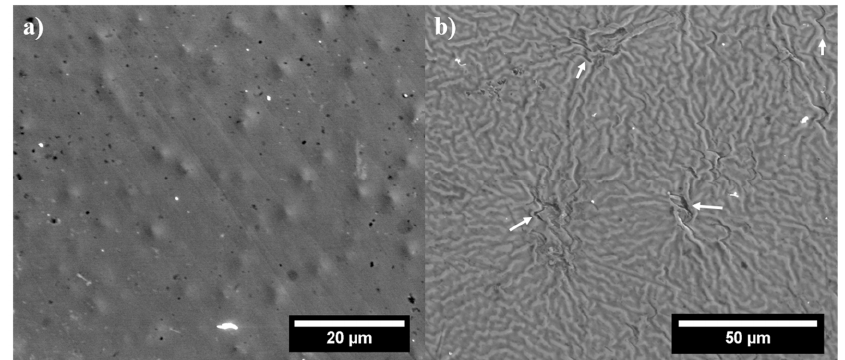
Figure A1. SEM images showing the morphology of Vit1b surface after CCT treatment a ) at 350 °C for 40 h and b ) at 380 °C for 4.5 h; several “cracks” are indicated using white arrows.